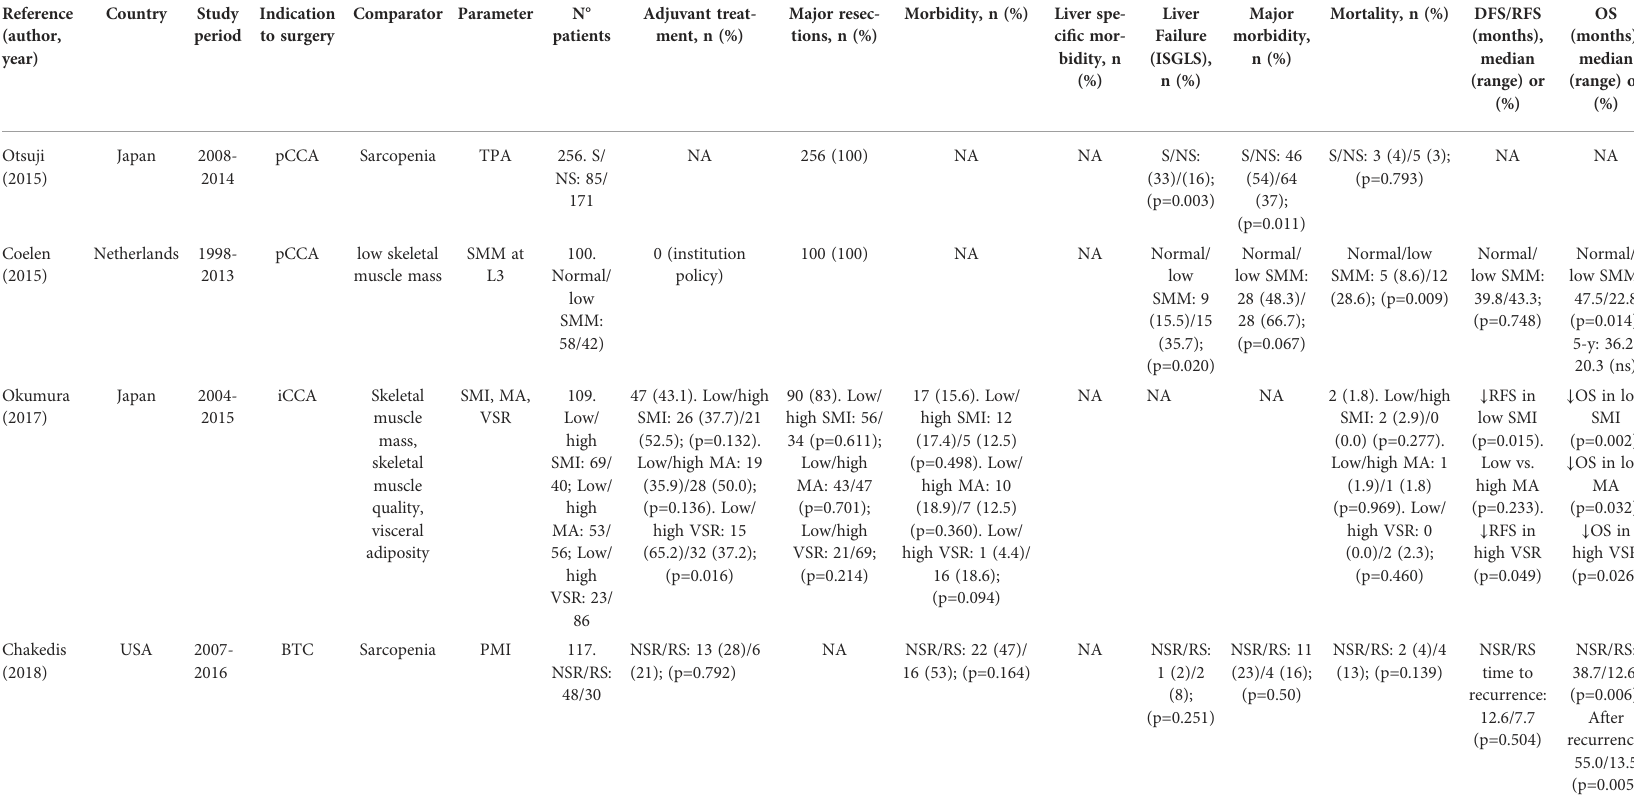
TABLE 4 Liver resection for cholangiocarcinoma